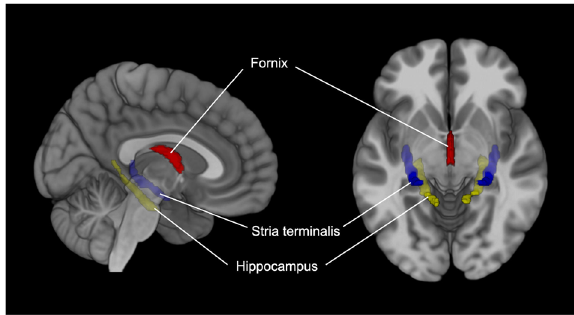
Fig. 1 White matter regions of interest. Hippocampal WM regions (hippocampal cingulum, fornix, and stria terminalis) were chosen as ROIsbased on the JHU DTI-based probabilistic tractography